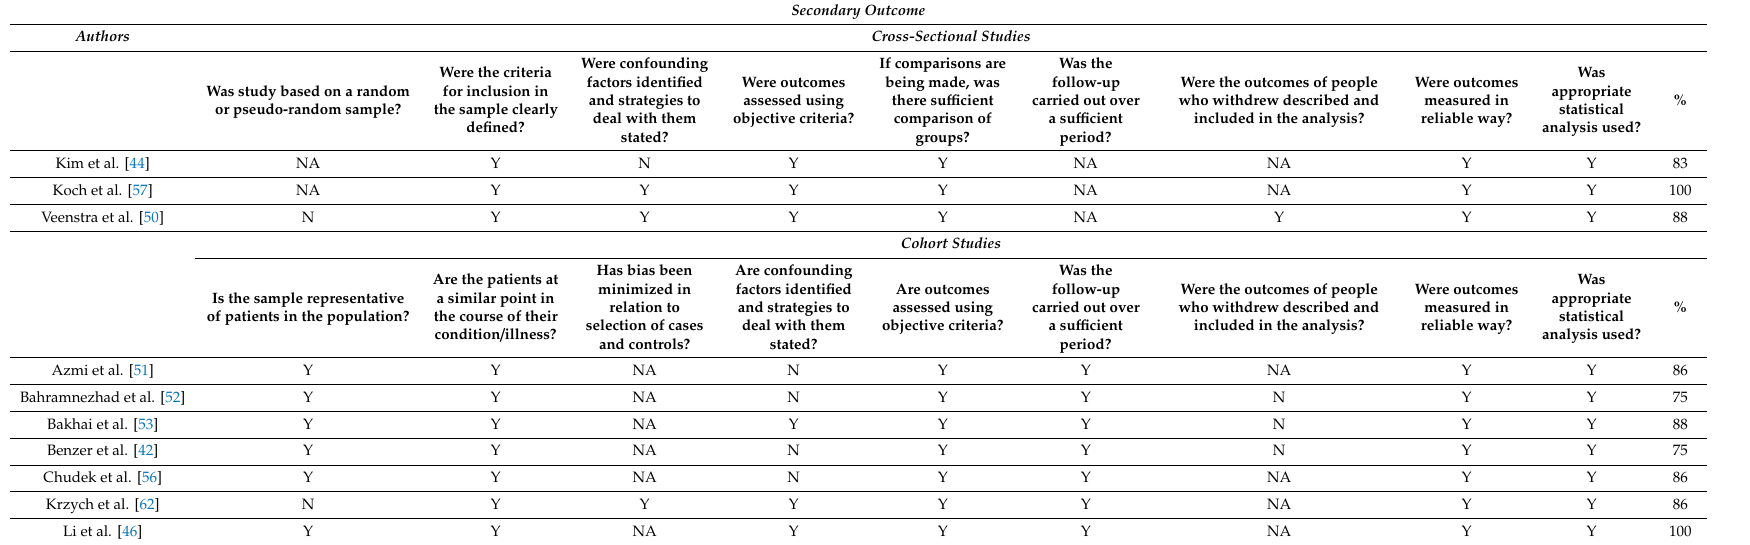
Table 2. Assessment of methodological quality of included studies ( n =